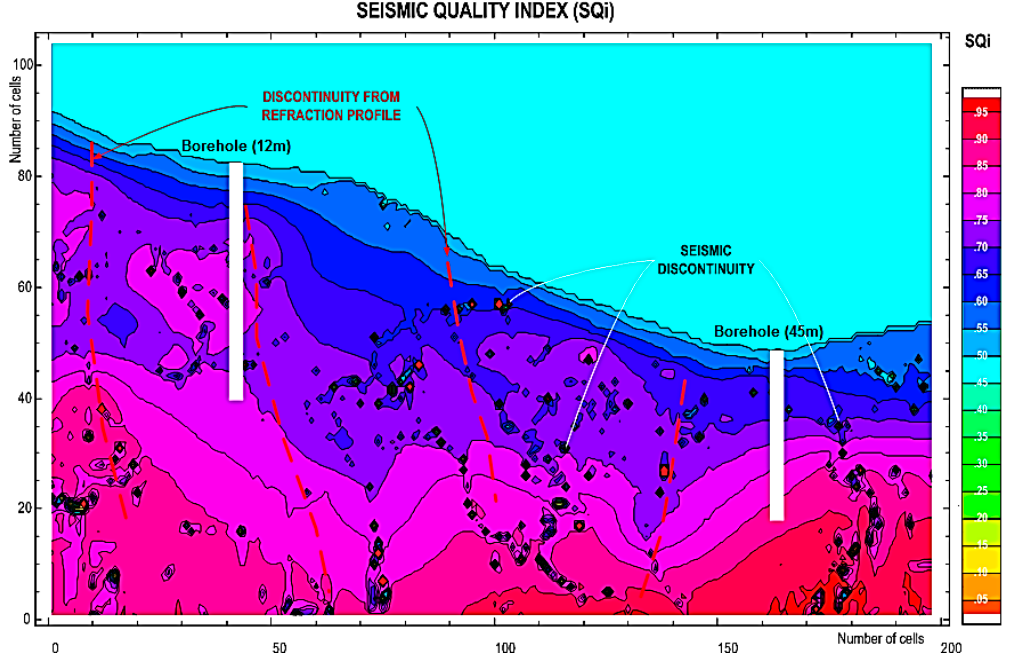
Figure 8. Seismic profile reconstruction for foundation design of a shopping mall in Rijeka, from [46].